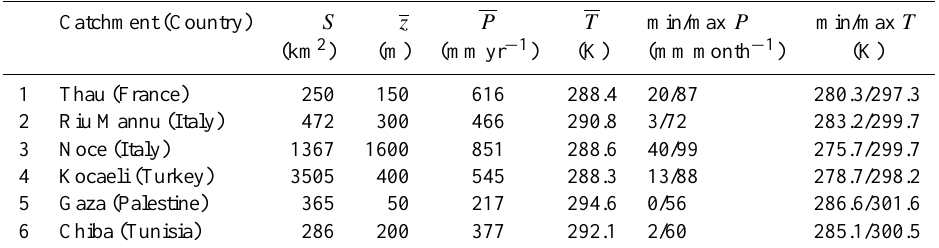
Table 1. Main topographic and 60yr (1951–2010) climatological characteristics of the considered catchments: area ( S ), mean elevation ( z ), mean annual precipitation ( P ) and sea level temperature ( T ), and minimum and maximum values of the monthly averages of precipitation and sea level temperatures.